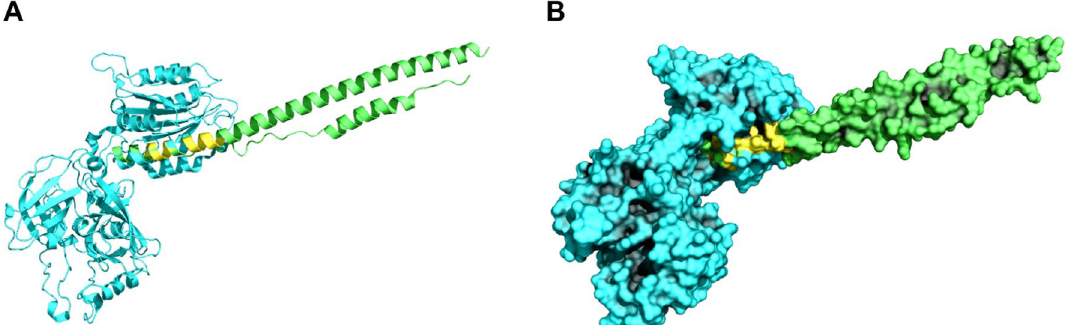
Figure 2. Surface matches between SARS-CoV-2 and complement factor B. We have included both a cartoon diagram (A) and a surface diagram (B) to show one of the human proteins (Complement Factor B, PDB ID: 1RTK, chain A, cyan) with structural homology to a SARS-CoV-2 protein (Spike Protein S2 subunit, PDB ID: 6LXT, chain A, green). This match (yellow) satisfied all of our criteria for inclusion as a significant match with an RMSD of 0.2 Å, an alignment score of 6.7, 15 aligned vertices, and sva value of 0.3 and an e-value of 1.43 × 10 –5